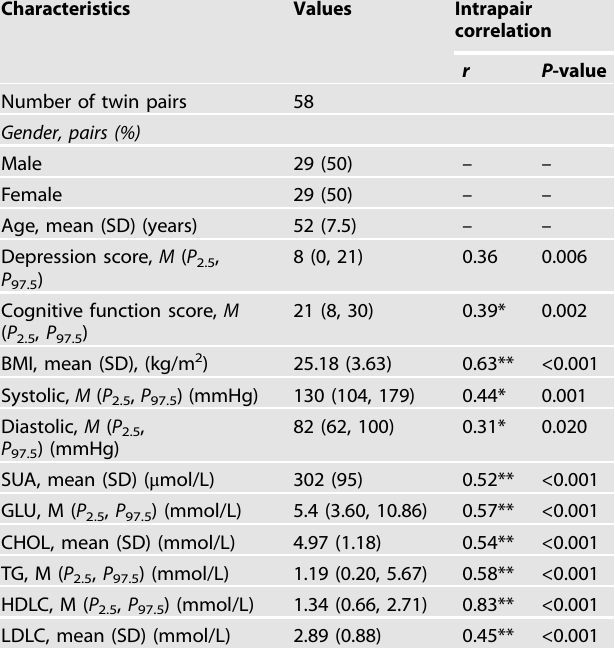
Table 1. Basic characteristics of the